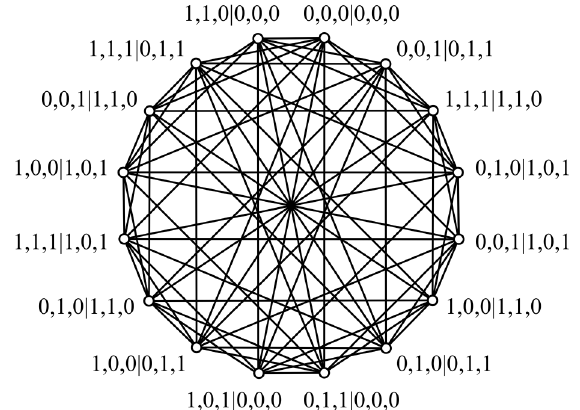
FIG. 2. Graph of exclusivity of the 16 events in the Bell wit- ness (C5) of the Mermin inequality. Here, Z and X are denoted 0 and 1, respectively, while − 1 and 1 are denoted 0 and 1, respec- tively. We refer to this graph as G M . It is the complement of the Shrikhande graph